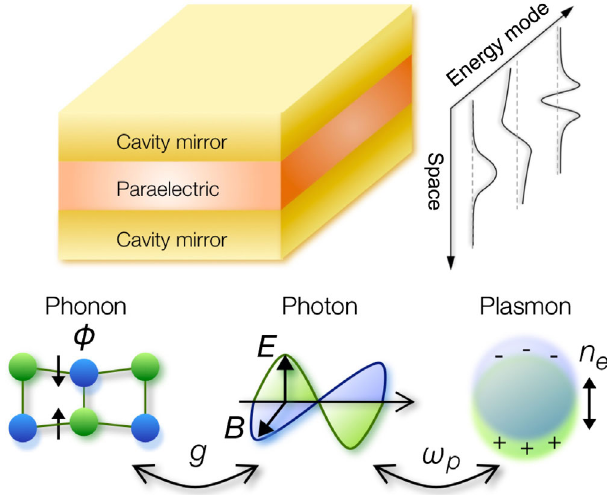
FIG. 2. Top: Setup of the heterostructure cavity configuration considered in the present manuscript. A slab of paraelectric material with a finite thickness is sandwiched between two semi- infinite metallic electrodes. The right represents spatial profiles of typical energy modes along the spatial direction perpendicular to the metal-insulator interfaces. Bottom: Schematic figure illus- trating three fundamental excitations relevant to the theory. A phonon excitation describes an optical collective mode induced by, e.g., the deformation of ionic crystals around the equilibrium configuration. More generally, it can also represent dipole moments of molecular solids or assembled organic molecules. The interaction between phonons and cavity photons is mediated by the dipole coupling, whose strength is represented by g . A plasmon, a collective excitation of electronic gases in metal mirrors, leads to the electromagnetic coupling characterized by the plasma frequency ω p